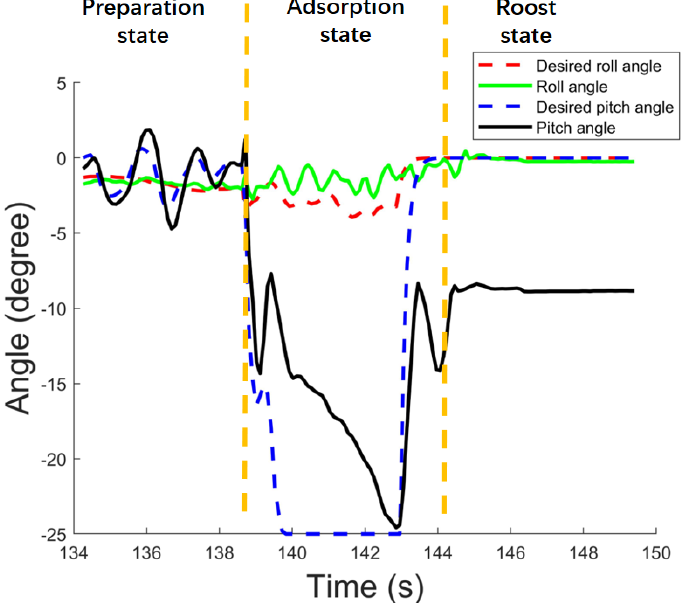
Figure 20. Attitude curve of the robot. (The different working states are divided by the yellow dotted line).